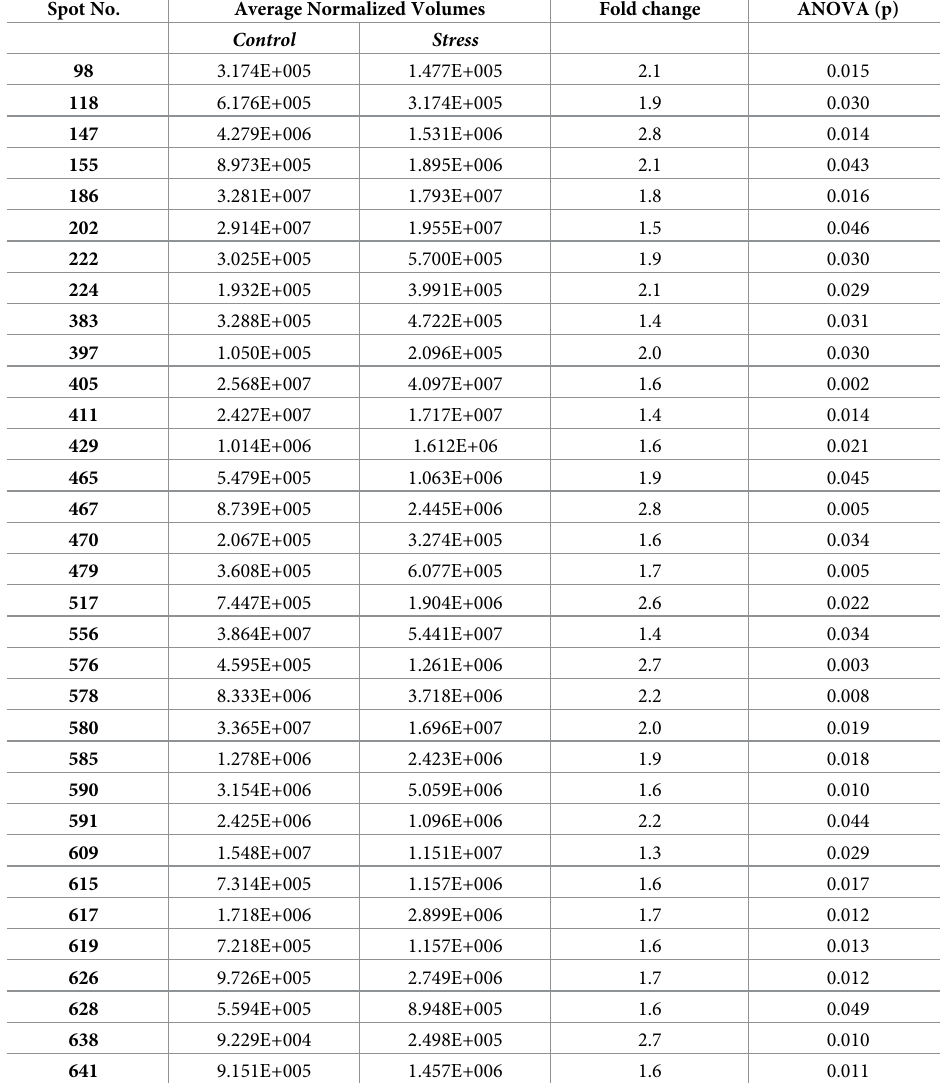
Table 1. The significantly altered 33 proteins between stress group and control. Spot